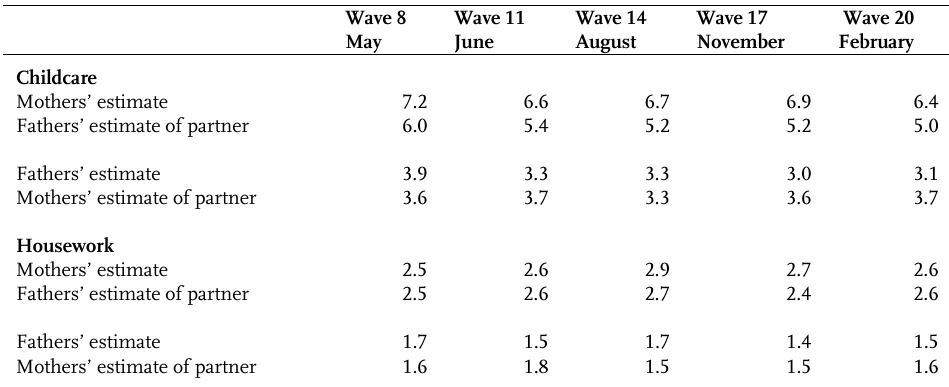
Table A1 : Comparison of mothers’/fathers’ estimates of own mean hours of childcare and housework with fathers’/mothers’ estimates of